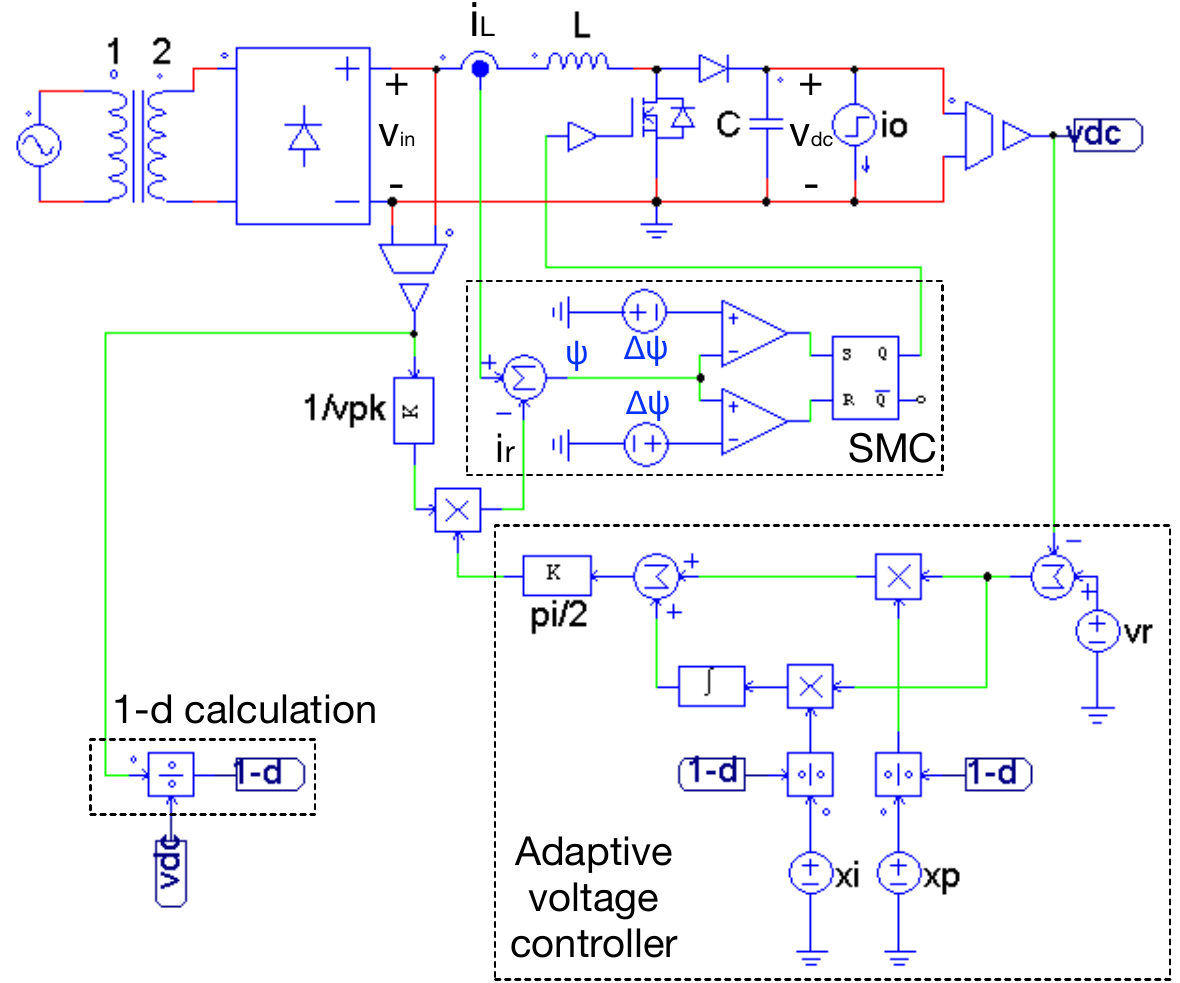
Figure 13. Application example implemented in the power electronics simulator